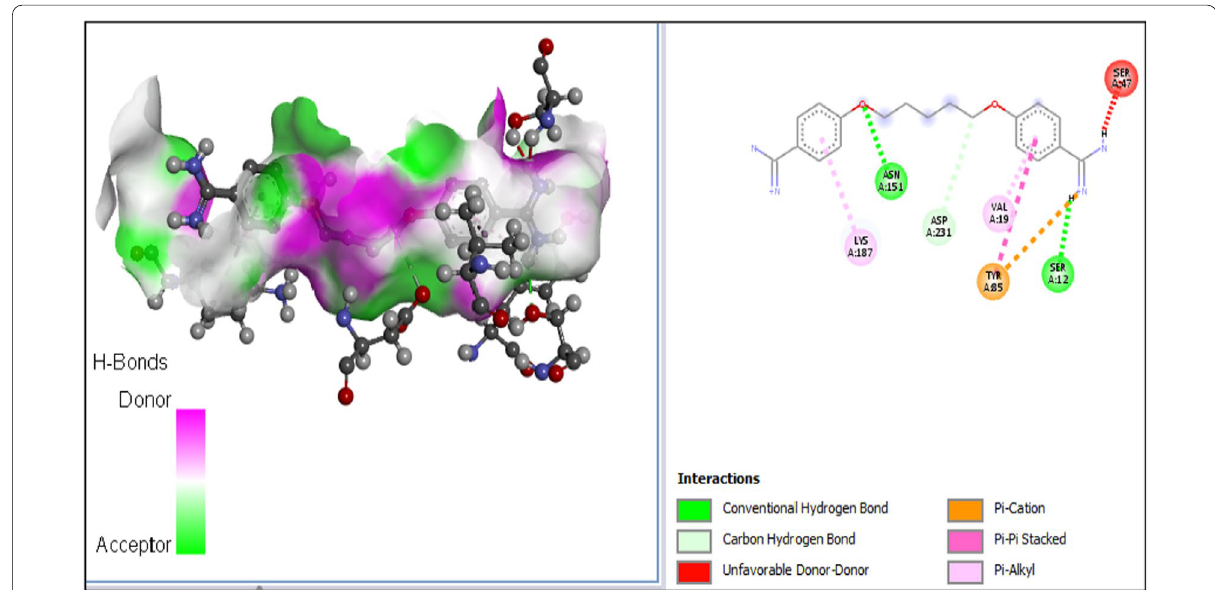
Fig. 8 2D and 3D view of the interaction between pentamidine and PdxK